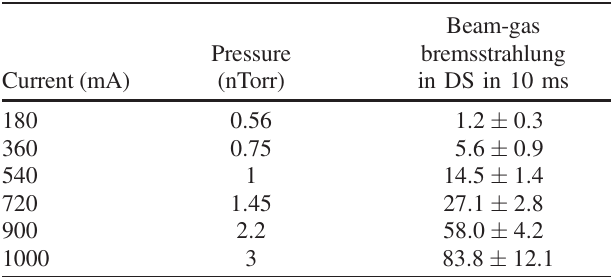
TABLE II. Measured losses from beam-gas bremsstrahlung in 10 ms in the DS for different beam currents and vacuum pressures in the LER.